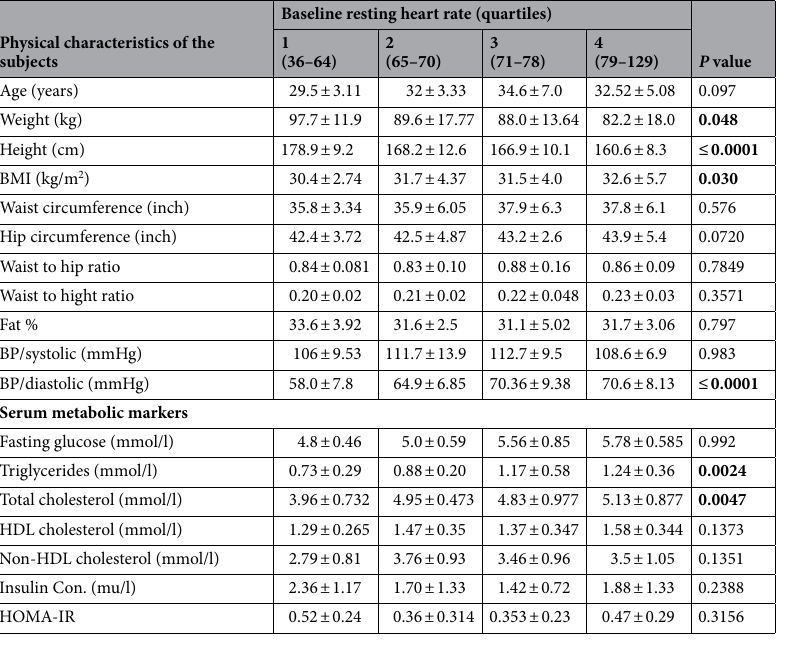
Table 2. Demographic and clinical characteristics of study population. Bold values denote statistical significance. All values are means ± standard deviations unless labeled otherwise. BMI body mass index, BP blood pressure, HR heart rate, HDL high-density lipoprotein, HOMA-IR homeostatic model assessment for insulin